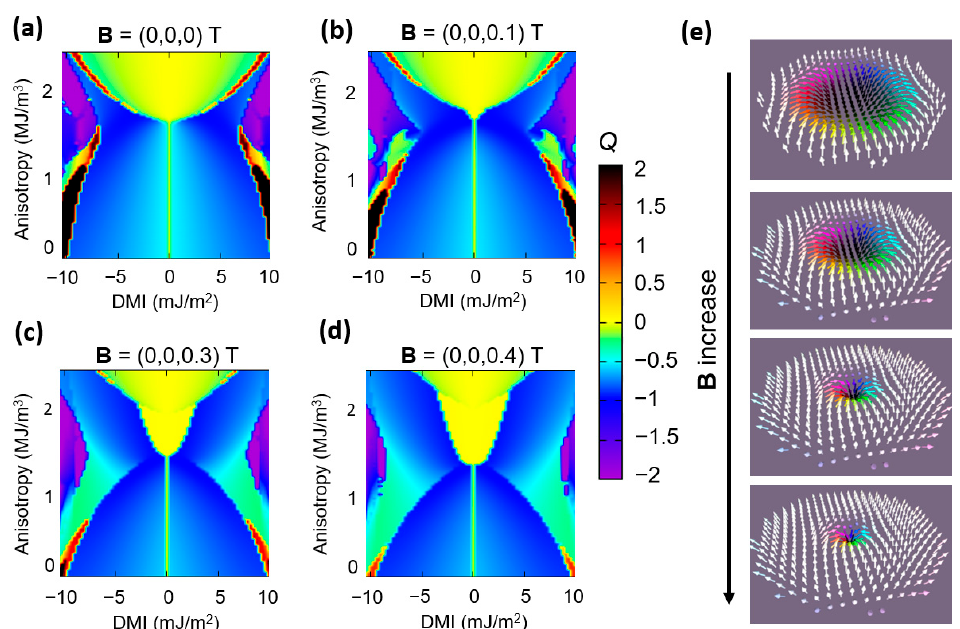
Figure 20. The influence of the magnetic field applied along the +Oz axis on the DMI-PMA-Q ground state phase diagram for a 90 nm disk. ( a ) B = 0 T ( b ) B = 0.1 T ( c ) B = 0.3 T ( d ) B = 0.4 T. ( e ) The variation of size of the skyrmion core with increasing magnetic field. The images correspond to a point (DMI = 5 mJ/m 2 , K u = 1.7 × 10 +6 J/m 3 ). The calculation has been performed for a 90 nm disk with the following fixed parameters: M s = 1714 kA/m, A ex = 2.1 × 10 +11 J/m; the Gilbert damping constant α = 0.01.